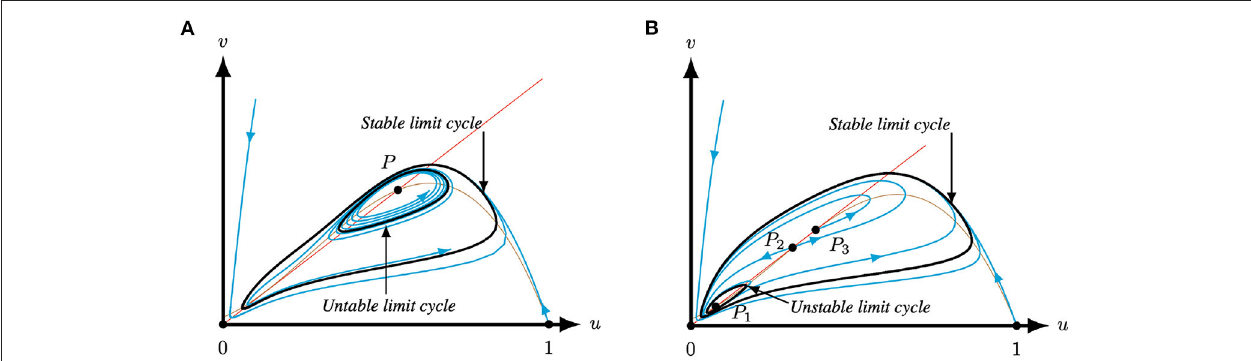
FIGURE 8 | Phase plane of system (4) for A represents the predator (prey) nullcline. (A) For Q outer limit cycle is stable. (B) For for Q cycles and P 3 is a repeller. The three positive equilibria P 1,2,3 are surrounded by a stable limit